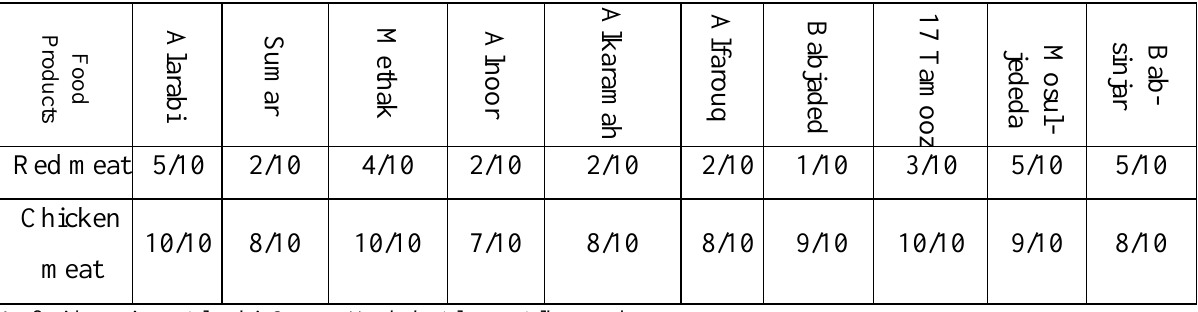
Left side regions: Alarabi, Sumar, Methak, Alnoor, Alkaramah Right side regions: Alfarouq, Babjaded, 17 Tamooz, Mosul-jededa, Bab-sinjar There were no significant differences between the markets of the right and left side in terms of displaying food products (animal origin) at room temperature, refrigeration or freezing. (P >